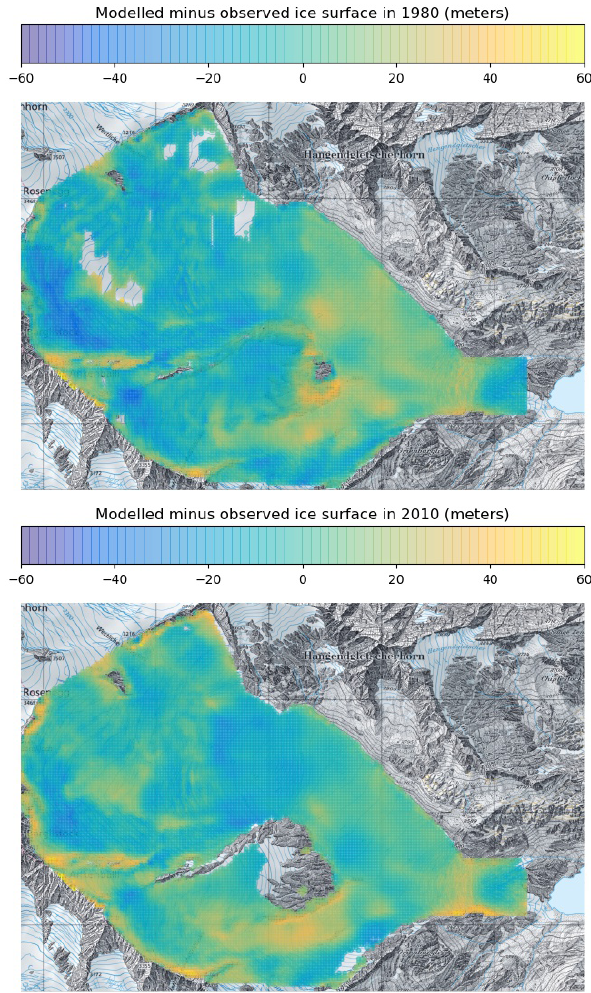
Figure B1. Modeled minus observed surface ice in 1980 (top panel) and 2010 (bottom panel) obtained with the best-guess model param- eter set (Fig. 4), i.e., with A = 100 and C P = 1 . 35. The correspond- ing root mean square error (RMSE) is given in Fig. 7a–b. Repro- duced by permission of swisstopo